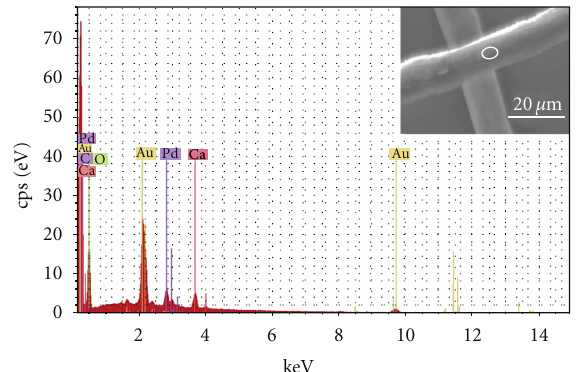
Figure 3: EDS spectrum of kenaf fiber treated with INI process at 100 ◦ C, Na 2 CO 3 : CaCl 2 = 1:2, mol:mol. The white circle designated the point that was